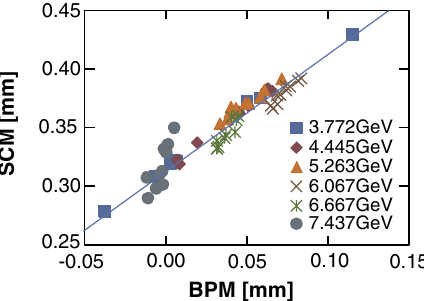
FIG. 32. Correlation plots between the center-mass positions taken with the BPM and SCM of BL3-2, while the electron beam energy was changed. Different energy data are indicated by the different color and shaped dots. The solid line shows the first order fitted data. Both the position data of the BPM and SCM have a good linear relation, and correlate within 10 (cid:1) m in rms.